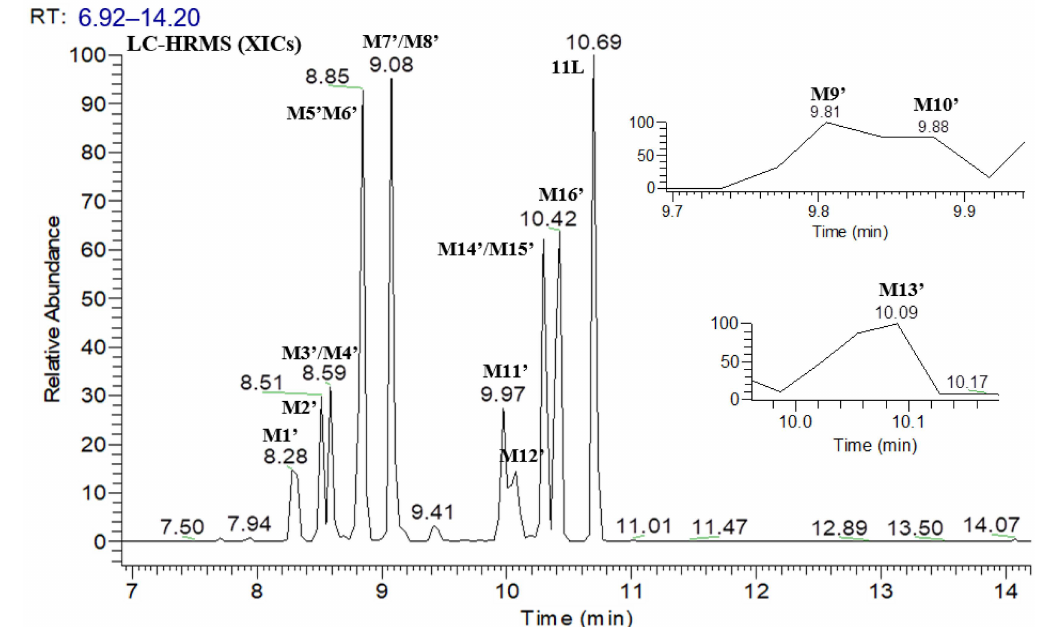
Figure 6. UPLC–UV (254–310 nm) chromatograms of 11L in HLMs: ( A ) UPLC–UV spectrum of T60; ( B ) UPLC–UV spectrum of T0; ( C ) blank UPLC–UV spectrum.